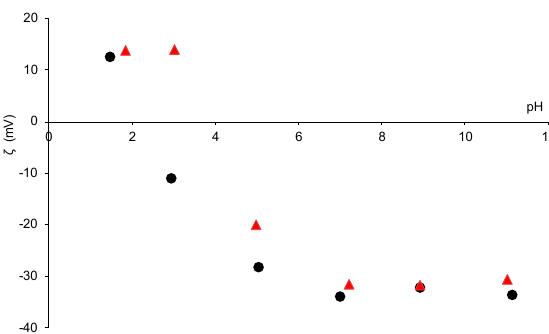
Figure 2. Zeta potential of Au@DTDTPA (black circles) and Au@DTDTPA-Cy5 (red triangles) as a function of pH.